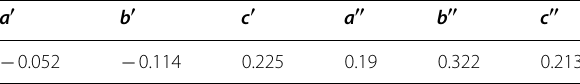
Table 5 Values of SFRC material